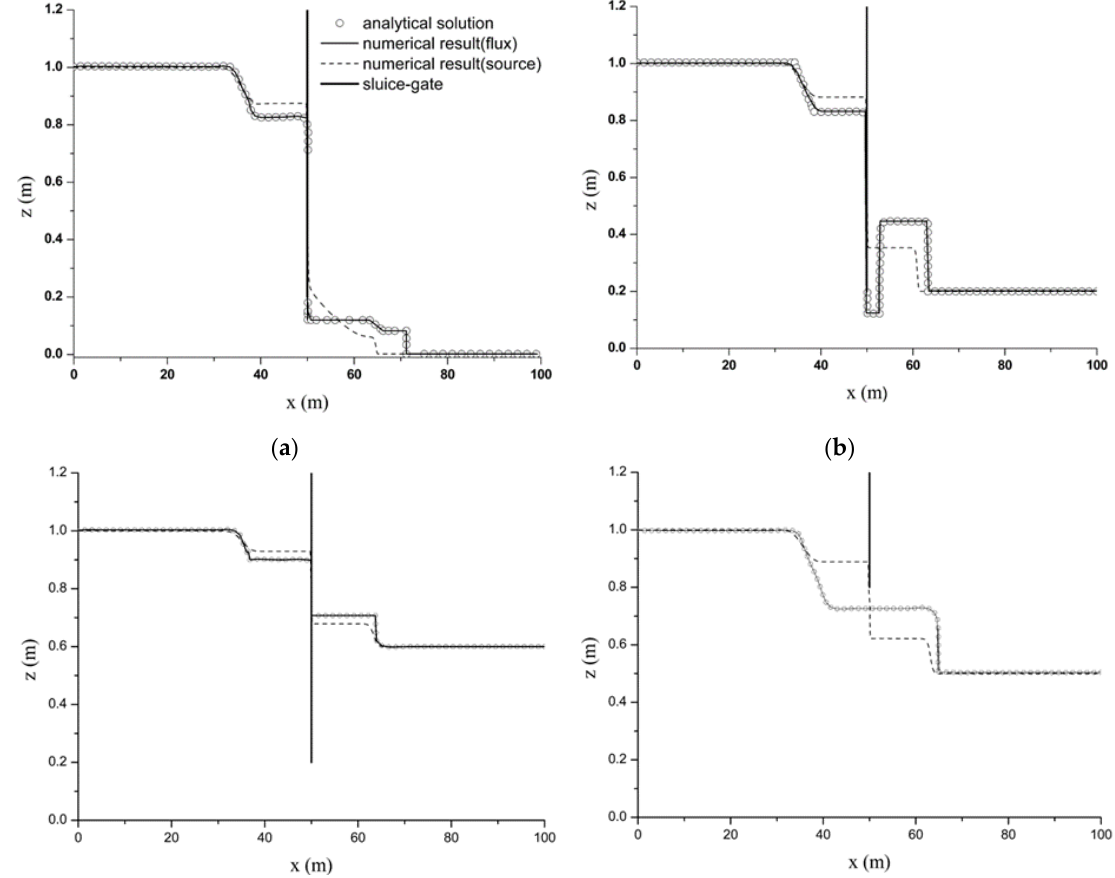
Figure 4. The numerical and analytical solutions (at t = 5 s) for the four test cases defined in Table 1: ( a ) Test 1. ( b ) Test 2. ( c ) Test 3. ( d ) Test